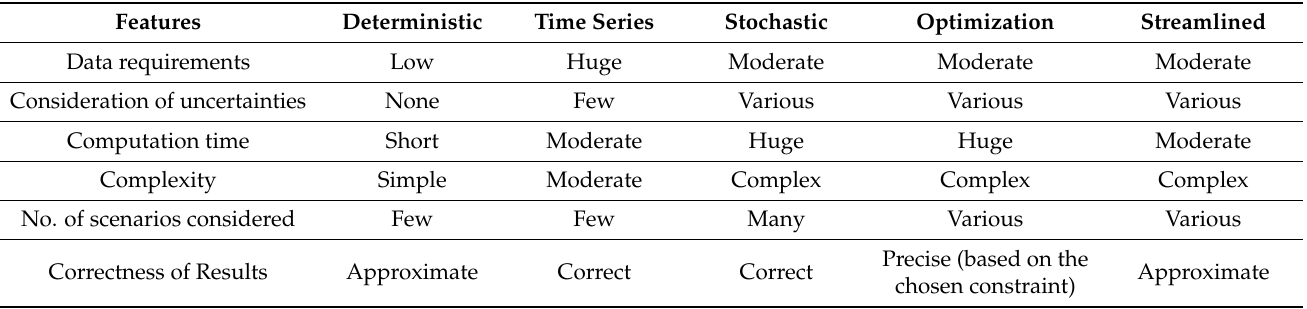
Table 9. Comparison of the different HC determination